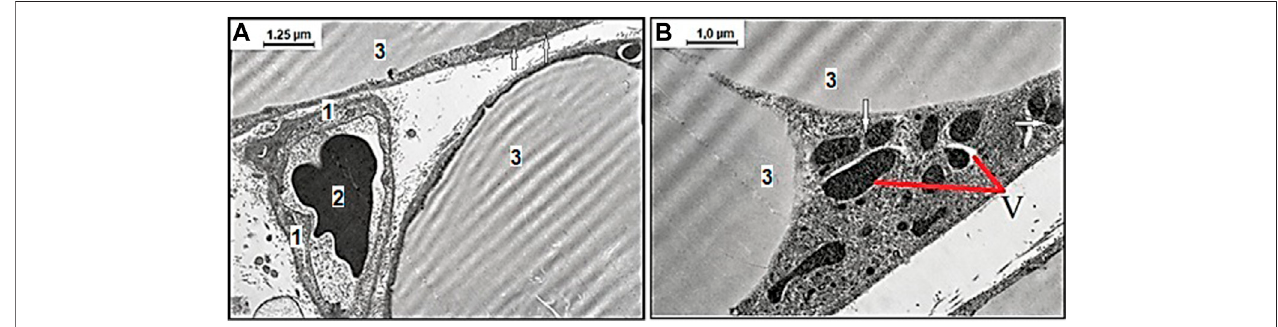
FIGURE 2 | Representative electron microscopy images of the age-related effect of ultrastructural examination of mesenteric material harvested from the area associated with the small intestine of adult (A) and aged (B) rats with the standard diet. (A) Among the connective tissues, there are well preserved capillary endothelial cells (CECs), 1) with erythrocyte 2) in the lumen surrounded with few adipocytes 3) without signs of fat fragmentation, and normal mitochondria (arrows mark) (original magni fi cation × 8,000). (B) The degenerating adipocyte with signs of vacuolization in the cytoplasm (V) and differently shaped electron-dense mitochondria. The